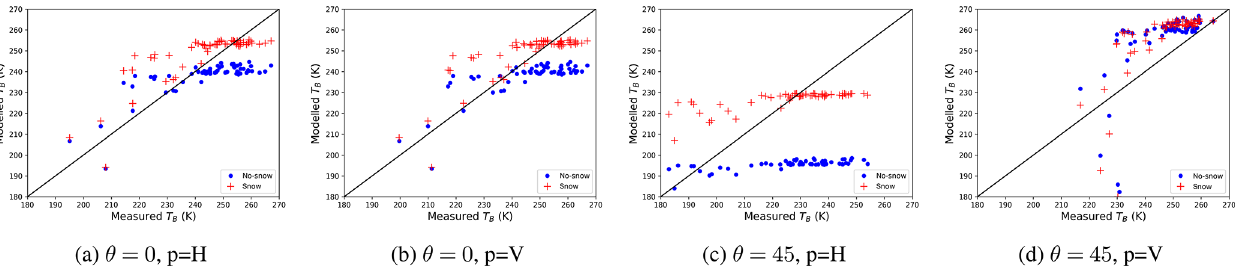
Figure 9. Scatter plots illustrating the comparisons between the EMIRAD-2 data and the T B simulated without GO roughness included – specular . Results corresponding to the setup with snow are marked in green, and without snow is in blue.